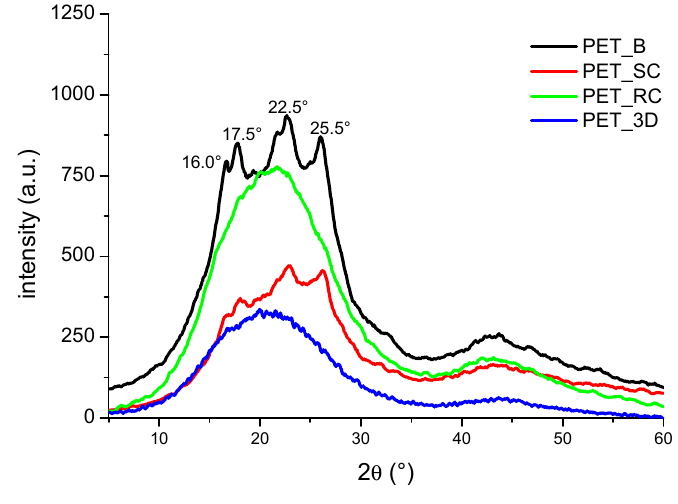
Figure 4. XRD of PET samples.